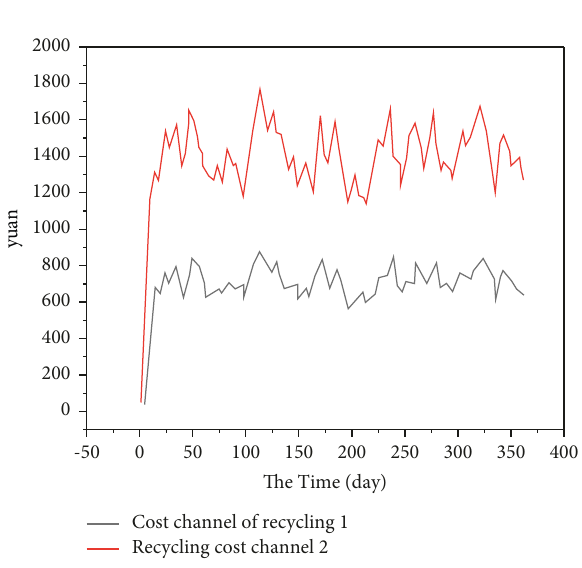
Figure 9: Cost of